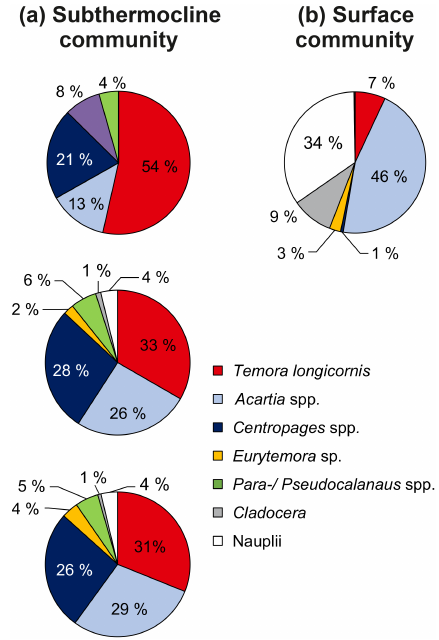
Figure 5. Relative zooplankton community composition of the three zooplankton grazing experiments listed in Table 1. (a) Sub- thermocline (used in experiments 1–3) and (b) surface zooplankton community composition (used in experiment 1). Adults and cope- podite stages C1–C5 were pooled for individual species, but Nauplii were pooled together for all copepod